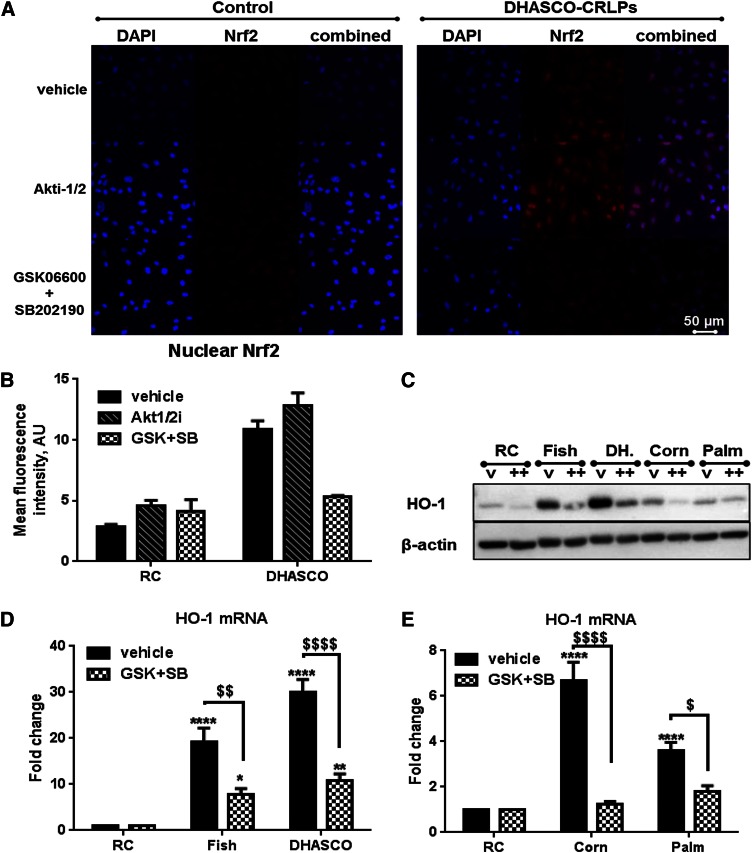
A-CRLPs increase Nrf2 expression and nuclear translocation via p38MAPK and PPARβ/δ. A, B: ECs were serum depleted for 1 h, pretreated (1 h) with vehicle, 1 μM Akt1/2i, or both GSK0660 and SB202190 (each 1 μM) then incubated with remnant control (Control) or DHASCO® A-CRLPs (280 μM TG) in the continued absence/presence of inhibitor(s) for 4 h. Cells were immunostained for Nrf2 (red) and nuclei labeled with DAPI (blue). No staining was evident in secondary antibody-only controls (not shown). Representative images are in (A) and combined mean nuclear Nrf2 fluorescence intensities from three separate images per condition are shown in (B) (mean ± SEM). C–E: Serum-starved HAECs were preincubated with vehicle or both 1 μM GSK0660 and 1 μM SB202190 (GSK+SB) for 1 h then incubated with A-CRLPs in the presence of vehicle or inhibitors for 4 h. C: Representative HO-1 and β-actin blots: vehicle (v), GSK+SB (++). D, E: HO-1 mRNA expression normalized to GAPDH. Data are fold change relative to remnant control (RC) (mean ± SEM, n = 3). Two-way ANOVA with Bonferroni’s multiple comparisons test: vehicle versus GSK+SB: $P < 0.05, $$P < 0.01, $$$$P < 0.0001. RC versus A-CRLP: *P < 0.05, **P < 0.01, ****P < 0.0001.